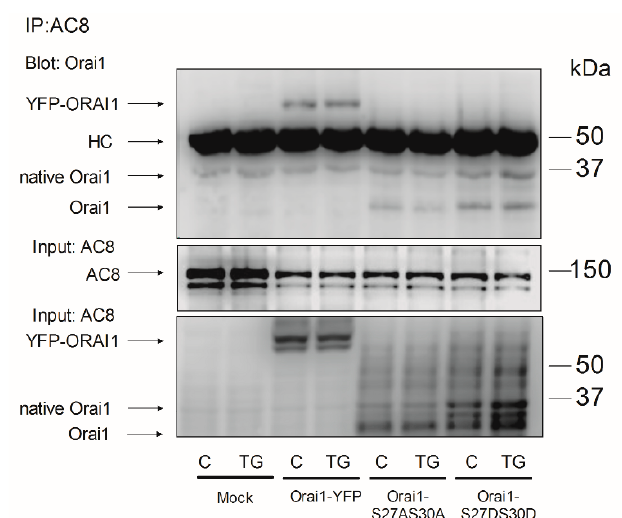
Figure 3. Role of Orai1 phosphorylation at Ser-27 and Ser-30 in the Orai1–AC8 interaction. MDA-MB-231 cells were transfected with pEYPF-Orai1, or the Orai1S27A/S30A and Orai1S27D/S30D mutants, or they were mock-treated, as indicated. Cells were then treated with 1 µM TG or the vehicle (C) and lysed 1 min later. Whole-cell lysates were immunoprecipitated (IP) with anti-AC8 antibody. Immunoprecipitates were subjected to 10% SDS-PAGE and subsequent Western blotting with specific anti-Orai1 antibody, as indicated. Membranes were reprobed with the anti-AC8 antibody for protein loading control. Alternatively, the cell lysates were subjected to 10% SDS-PAGE and subsequent Western blotting with anti-Orai1 antibody. The panels show results from one experiment representative of five others. Molecular masses indicated on the right were determined using molecular-mass markers run in the same gel. HC: heavy chain of the antibody used for immunoprecipitation; native Orai1: post-translationally modified Orai1; Orai1: Orai1 without post-translational modifications.